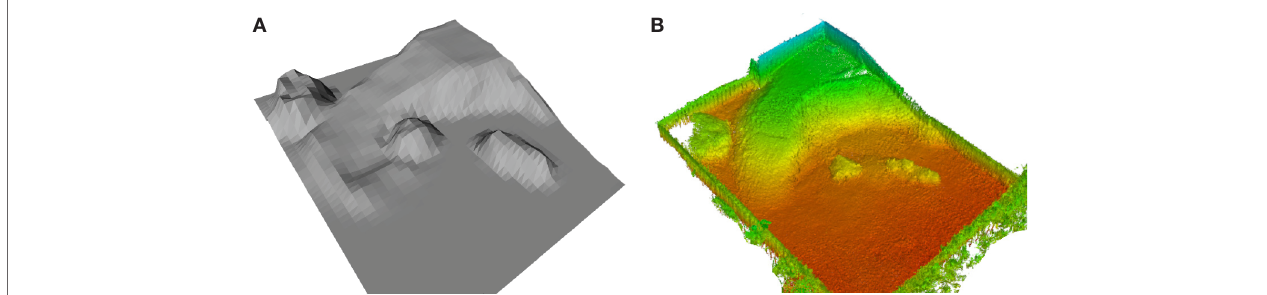
FIGURE 12 | Map refinement . (A) Rough map of the SpaceBot Camp 2015 arena. (B) The resulting global map from data acquired during the competition.